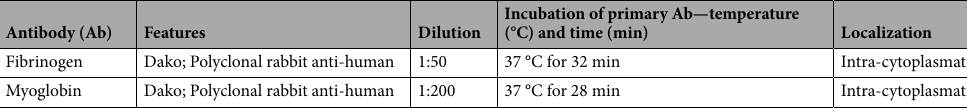
Table 1. Characteristics of antibodies used for IHC